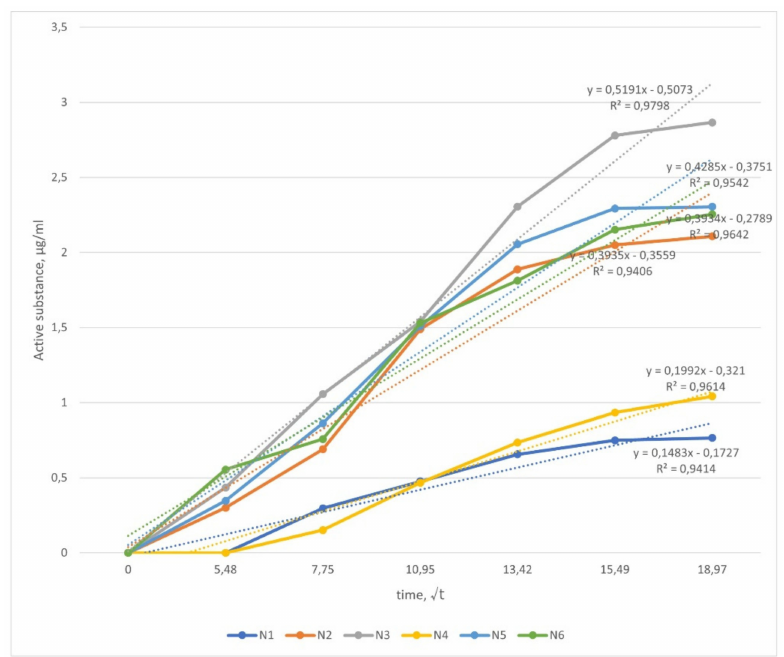
Figure 3. In vitro profile of 10-HDA release from selected microemulsion